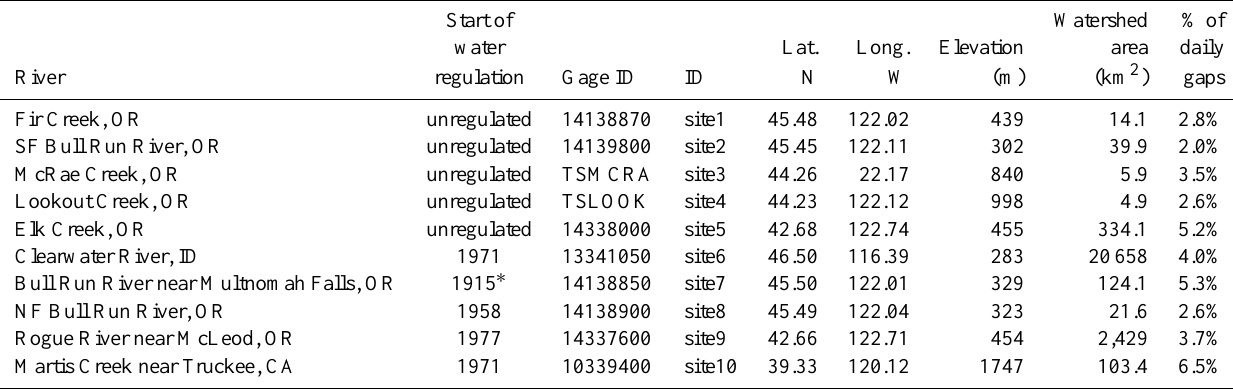
Table 1. Location and characteristics of unregulated ( n = 5) and regulated ( n = 5) streams at the gaging sites. Percent of daily gaps in the stream temperature time series from January 1979 to December 2009 used in this study. Start of Watershed % of water Lat. Long. Elevation area daily River regulation Gage